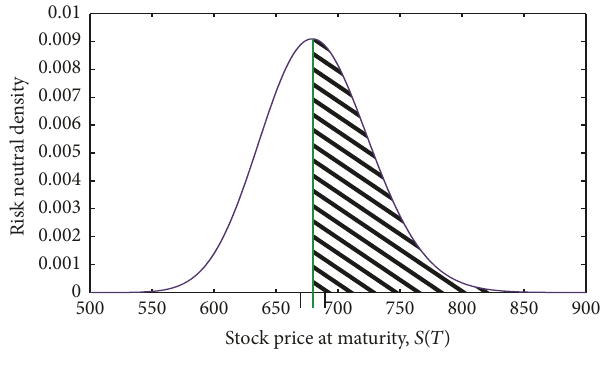
Figure 6: Asymmetry perception.